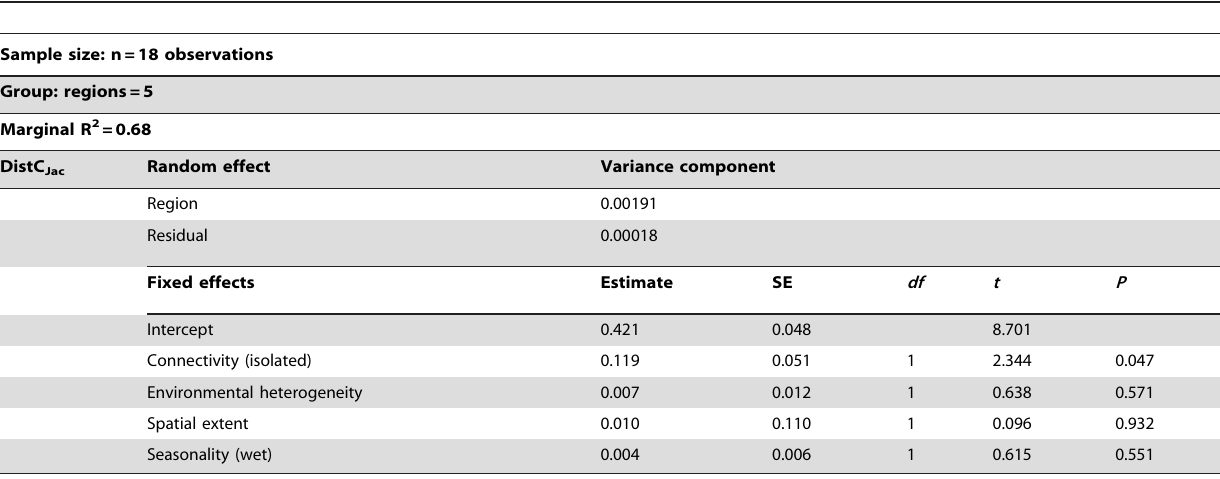
Table 1. Summary of the linear mixed-effects model of zooplankton beta diversity measured as the mean1-Jaccard distance to group (DistC Jac ) centroid for connectivity data (connected and isolated permanent lakes from all study regions).